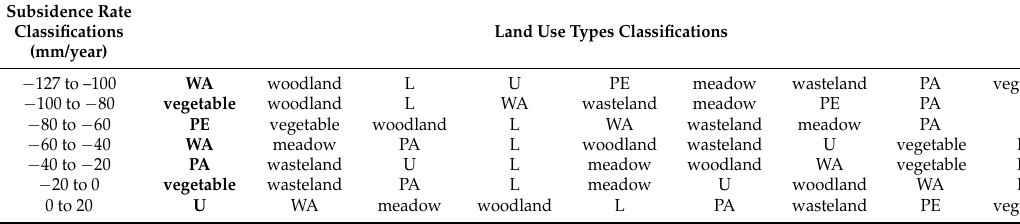
Table 5. The sequence of the relationship between land use types and land subsidence rate. From left to right, the correlation between land subsidence and land use types decreases gradually. WA (water area and wetland); L (large industrial zones airport and other special land); U (urban construction land); PE (peasant-inhabited land); WS (wasteland); PA (paddy field and upland